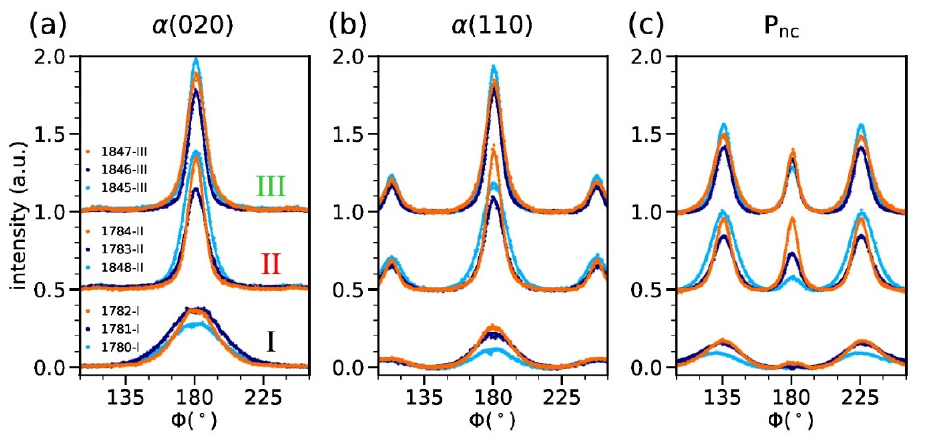
Figure 10. Azimuthal profiles of annulus around the equatorial reflections of ( a ) α (020), ( b ) α (110) and ( c ) P nc . The curves of fibers melt-spun from different polymer grades have been offset by 0.5 for better visibility.